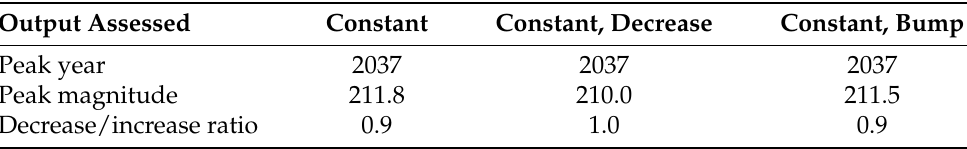
Table 7. Dependence of the results on the decline year hypotheses.